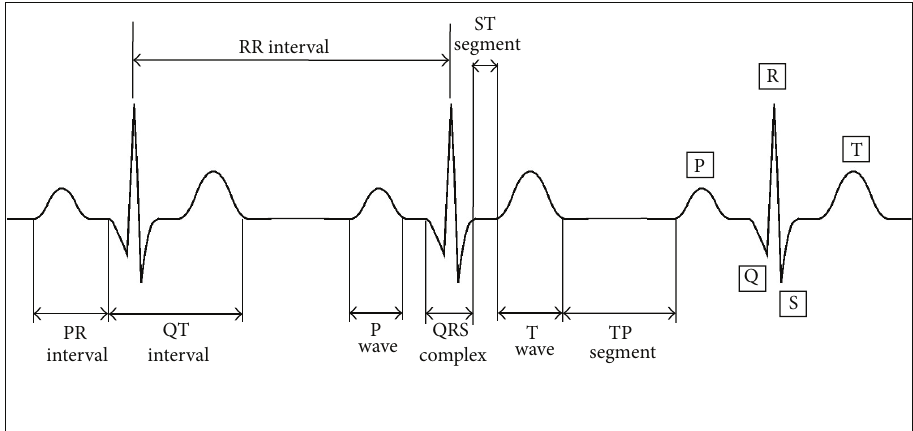
Figure 1: A typical ECG signal that includes three successive heartbeats and the information lying in the P, Q, R, S and T waves.